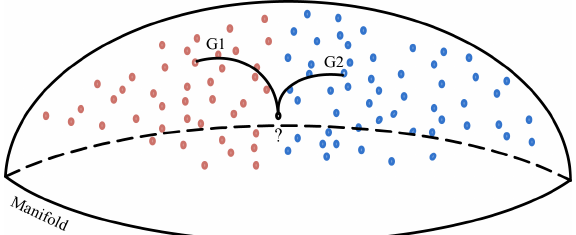
Figure 4. The Riemannian minimum distance to the mean for classification problems. Two types of Riemannian Geometry mean (G1 and G2) are calculated from the training data. When the data to be classified (indicated by a question mark) come in, they are classified as the ones whose Riemannian distances is